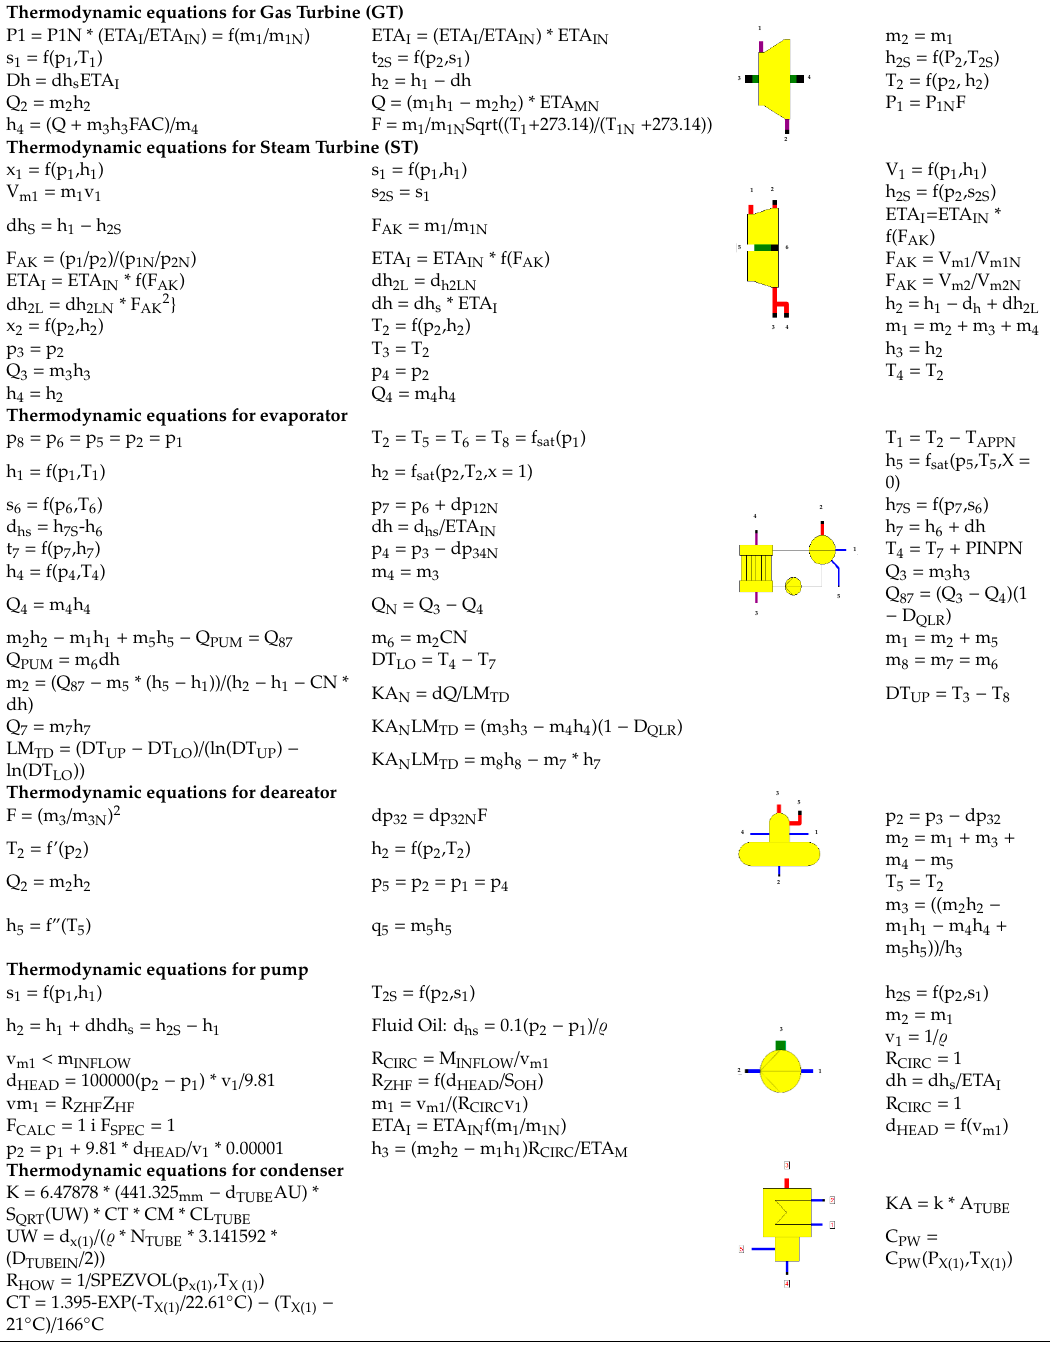
Table 4. General model formulations.